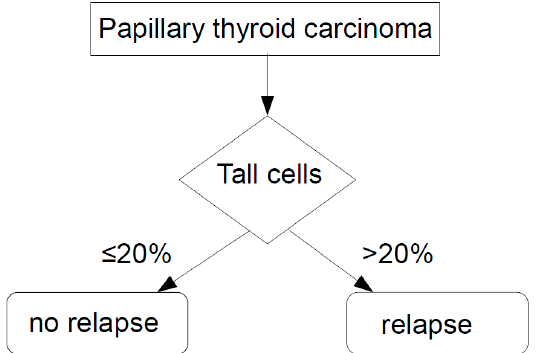
Figure 3. decision tree with tall cells (TC) to determine relapse free survival (RFS) in PTC, overall accuracy 73.6%.